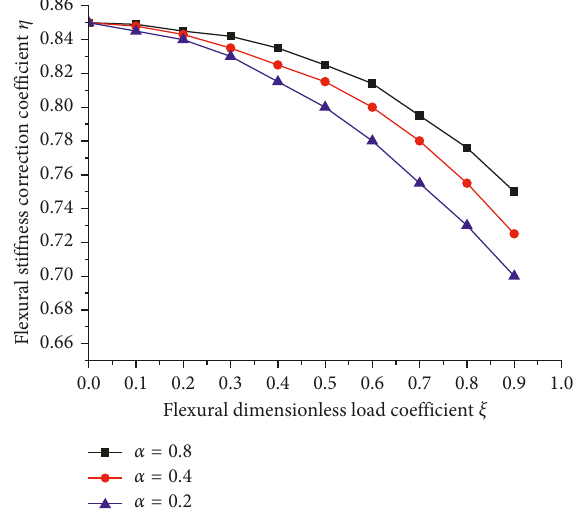
Figure 9: Effect of the contact area on η